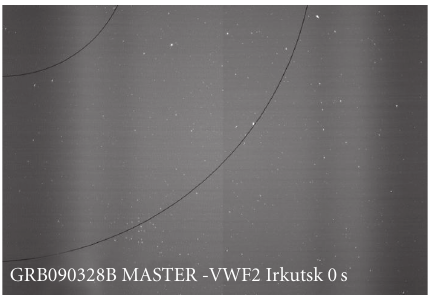
Figure 19: MASTER-VWF4 Kislovodsk GRB090305B follow-up observation. This is a 40 ◦ × 24 ◦ full-frame image. The white and black circles show the error boxes corresponding to the 1 and 3 sigma FERMI error limits plus the 3 ◦ systematic error [12] ( R 1sigma = 5 . 4 ◦ ). The black rectangle shows the IPN triangulation error-box Animation is available here http://observ.pereplet.ru/